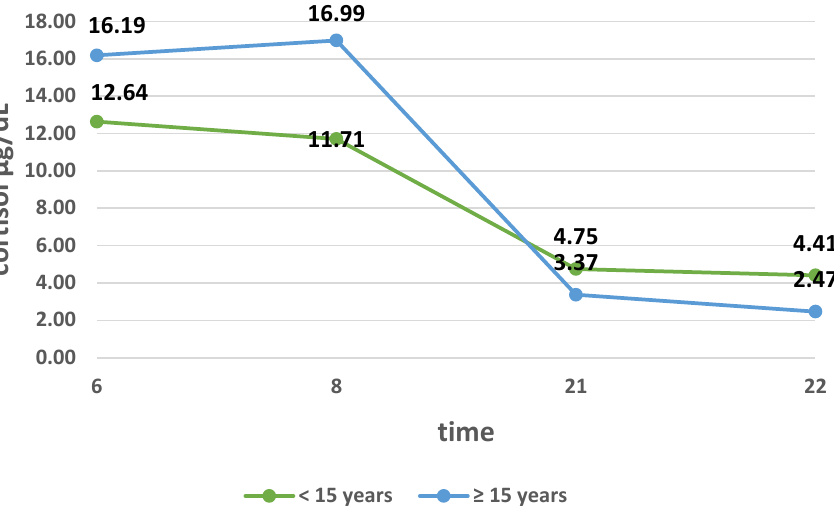
Figure 4. Diurnal cortisol profile depending on seniority.